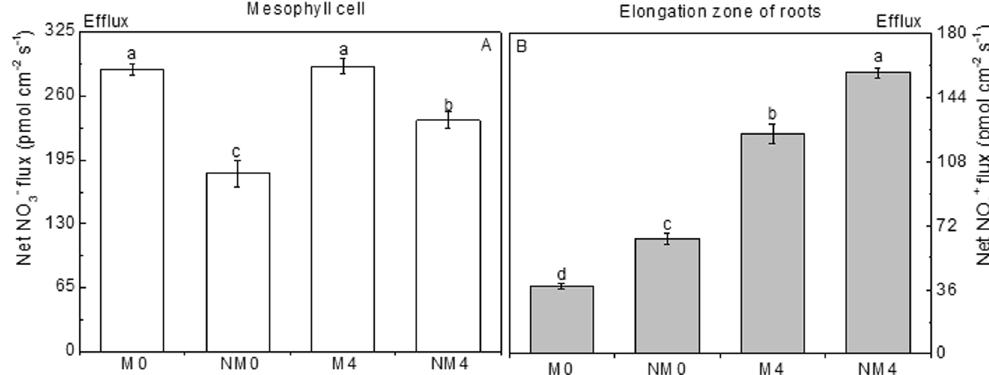
Figure 2. Changes in net NO 3 − flux in mesophyll cells ( A ) and in the elongation region ( B ) within 10 min at 15 mm from the root tips of Neva irrigated with magnetized and non-magnetized brackish water. The means ± SEs (n > 3) of the values obtained for mesophyll cells and the elongation region are shown. Values followed by different lowercase letters represent statistically significant differences at the 0.05 probability